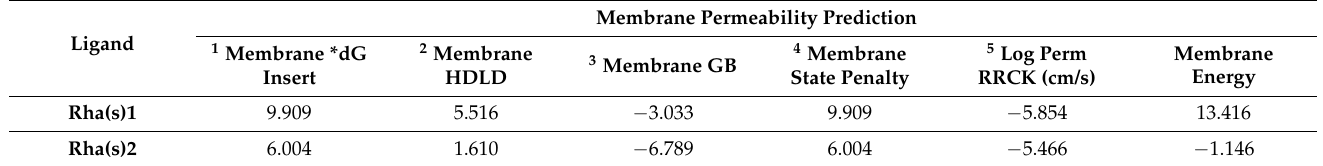
Figure 7. In silico docking study revealing interactions between ( A ) Rha(s)1 and ( B ) Rha(s)2 with the active sites of SARS-CoV2 main protease. PDB accession number for main protease is 6Y2G. The interactions of Rha(s)1 and 2 with EndoRNAse involved the formation of five and four hydrogen bonds, respectively. For Rha(s)1, the hydrogen bonds formed with Glu 41 chain (B), Glu 44 chain (B), Glu 41 chain (F) and Glu 266 chain (D) (Table 4 and Figure 4A), whereas for Rha(s)2, the hydrogen bonds formed with Asp 91 chain (B) and Glu44 chain (F) (Table 4 and Figure 4B). The total intermolecular free energy recorded for Rha(s)1 and 2 interactions with EndoRNAse was 21 and 11.5 kcal/mol, respectively (Table 4). The interactions of Rha(s)1 and 2 with helicase involved the formation of three and four hydrogen bonds, respectively. For Rha(s)1, the hydrogen bonds formed with Gln 537, Glu 375, Lys 288 and Ser 536 (Table 4 and Figure 5A), whereas for Rha(s)2, the hydrogen bonds formed with Ala 509, Glu 540, and Lys 508 and Tyr 541 (Table 5 and Figure 5B). The total intermolecular free energy recorded for Rha(s)1 and 2 interactions with helicase was 14 and 5.7 kcal/mol, respectively (Table 4). Table 5. Computational membrane permeability of rhamnolipids